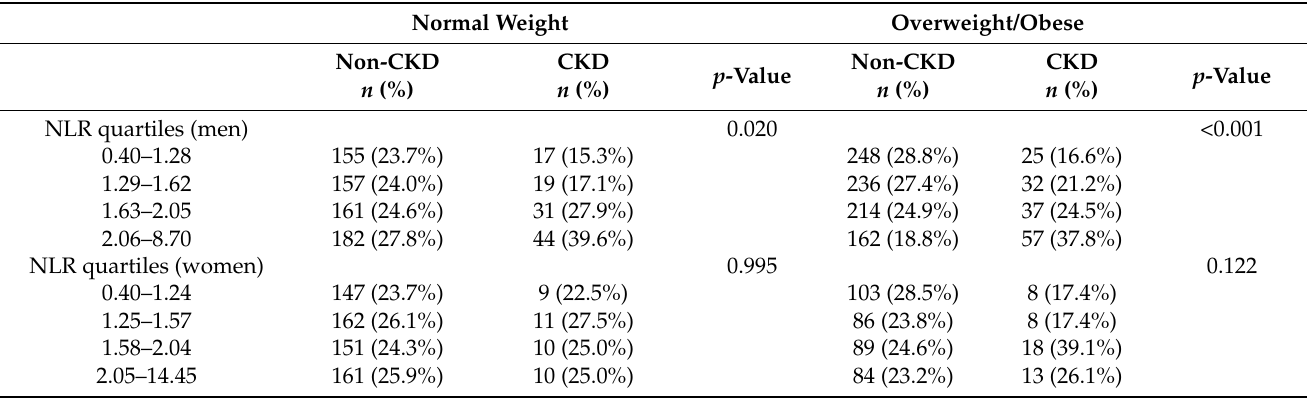
Table 3. NLR quartile percentages in normal-weight and overweight/obese men and women with and without CKD.